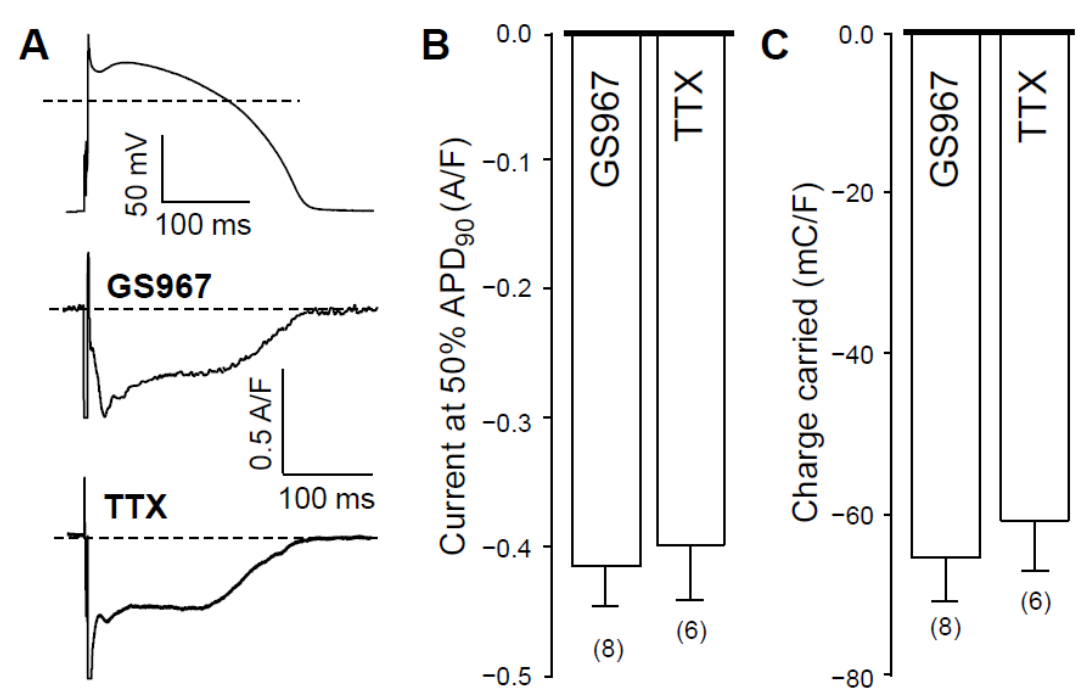
Figure 1. Effects of GS967 and TTX on I NaL in isolated canine ventricular myocytes under action potential voltage-clamp conditions. ( A ) representative membrane current records dissected by 1 µM GS967 and 10 µM TTX in Tyrode solution. The command AP is shown above current traces. Dashed lines indicate zero voltage and current levels. ( B ) Current densities measured at 50% of APD 90 . ( C ) Current integrals (charge carried) from which the initial 20 ms period were excluded. Columns and bars denote mean ± SEM values, numbers in parentheses indicate the number of myocytes studied.